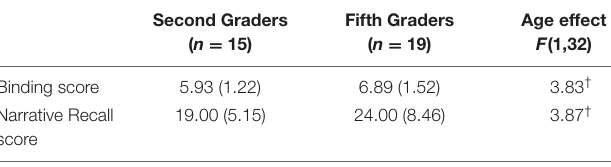
TABLE 1 | Mean total scores (standard deviation) of the Second and Fifth Graders for the complementary cognitive assessment battery and ANOVAs